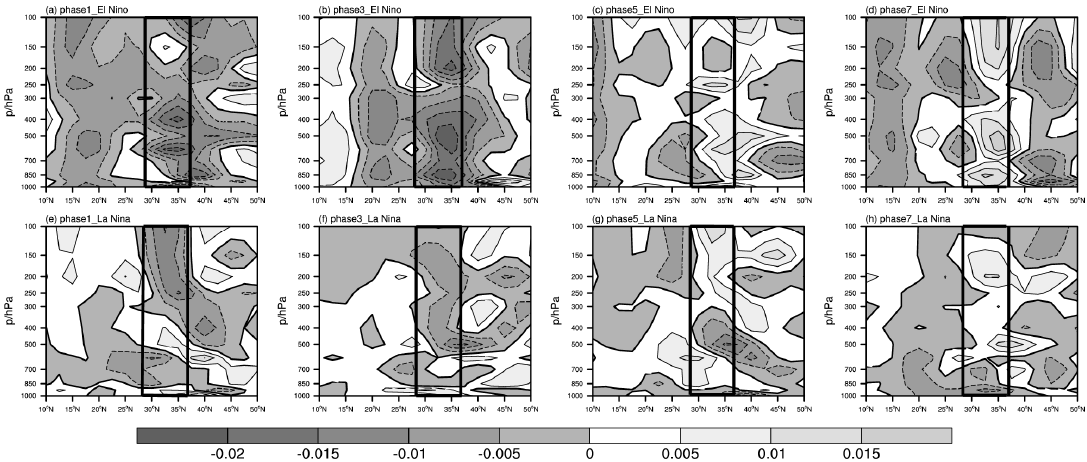
Figure 9. Same as Figure 5, but for the 10–20 d low-frequency vertical velocity field profiles along the mean 108–118° E meridian in eastern China (units: pa·s − 1